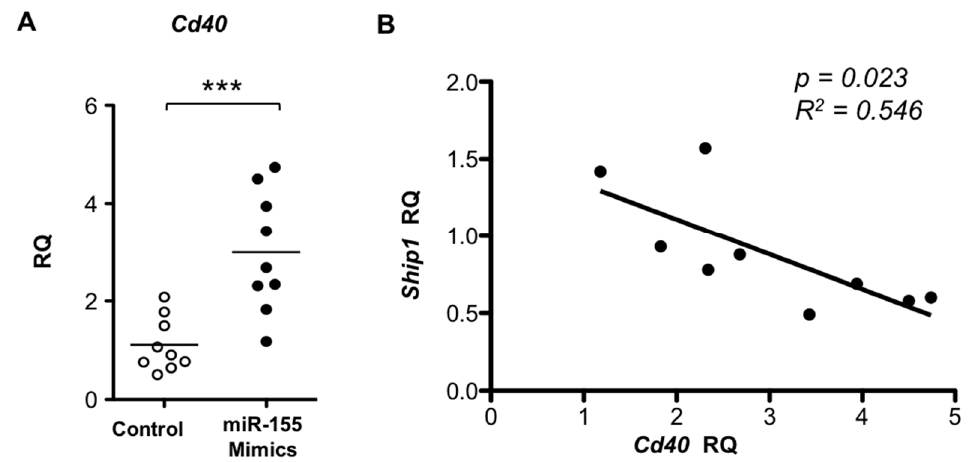
Figure 6. Transfection of miR-155 induces upregulation of Cd40 in pre-symptomatic pDCs. ( A ) Pre-symptomatic pDCs were transfected with miR-155 mimics or scramble mimics control (control). The expression levels of Cd40 in miR-155-transfected pDCs were examined by real time PCR and presented as relative quantity (RQ) to their respective mean expression in the control group. Bar: mean value. *** p ≤ 0.001 (unpaired two-tailed Student’s t -test); ( B ) Correlation of Cd40 induction vs. Ship1 suppression upon transfection of miR-155 mimics was plotted. The expression levels are presented as RQ relative to their respective average of controls in each group. The coefficient of correlation (R 2 ) and p value were determined by linear regression. Each symbol represents one experimental mouse. Data were collected from at least three independent experiments ( n = 9).